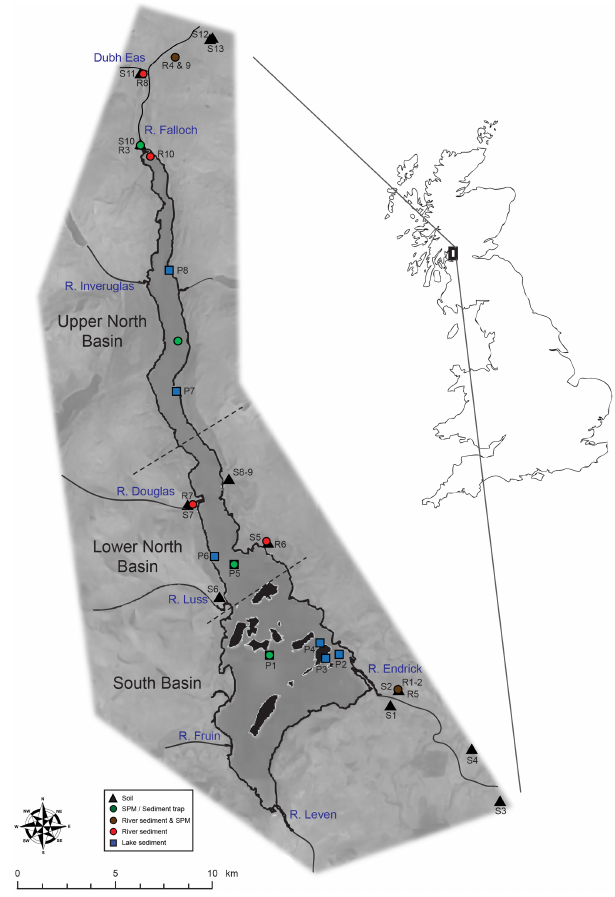
Figure 1. Map of Loch Lomond and coded sample locations (see Tables 1–5). Black patches in the south basin represent islands; black boxes and their associated labels at the sediment trap and SPM locations (green circles) refer to the sediment collected from the same location. The extent of catchment rivers is represented by smoothed